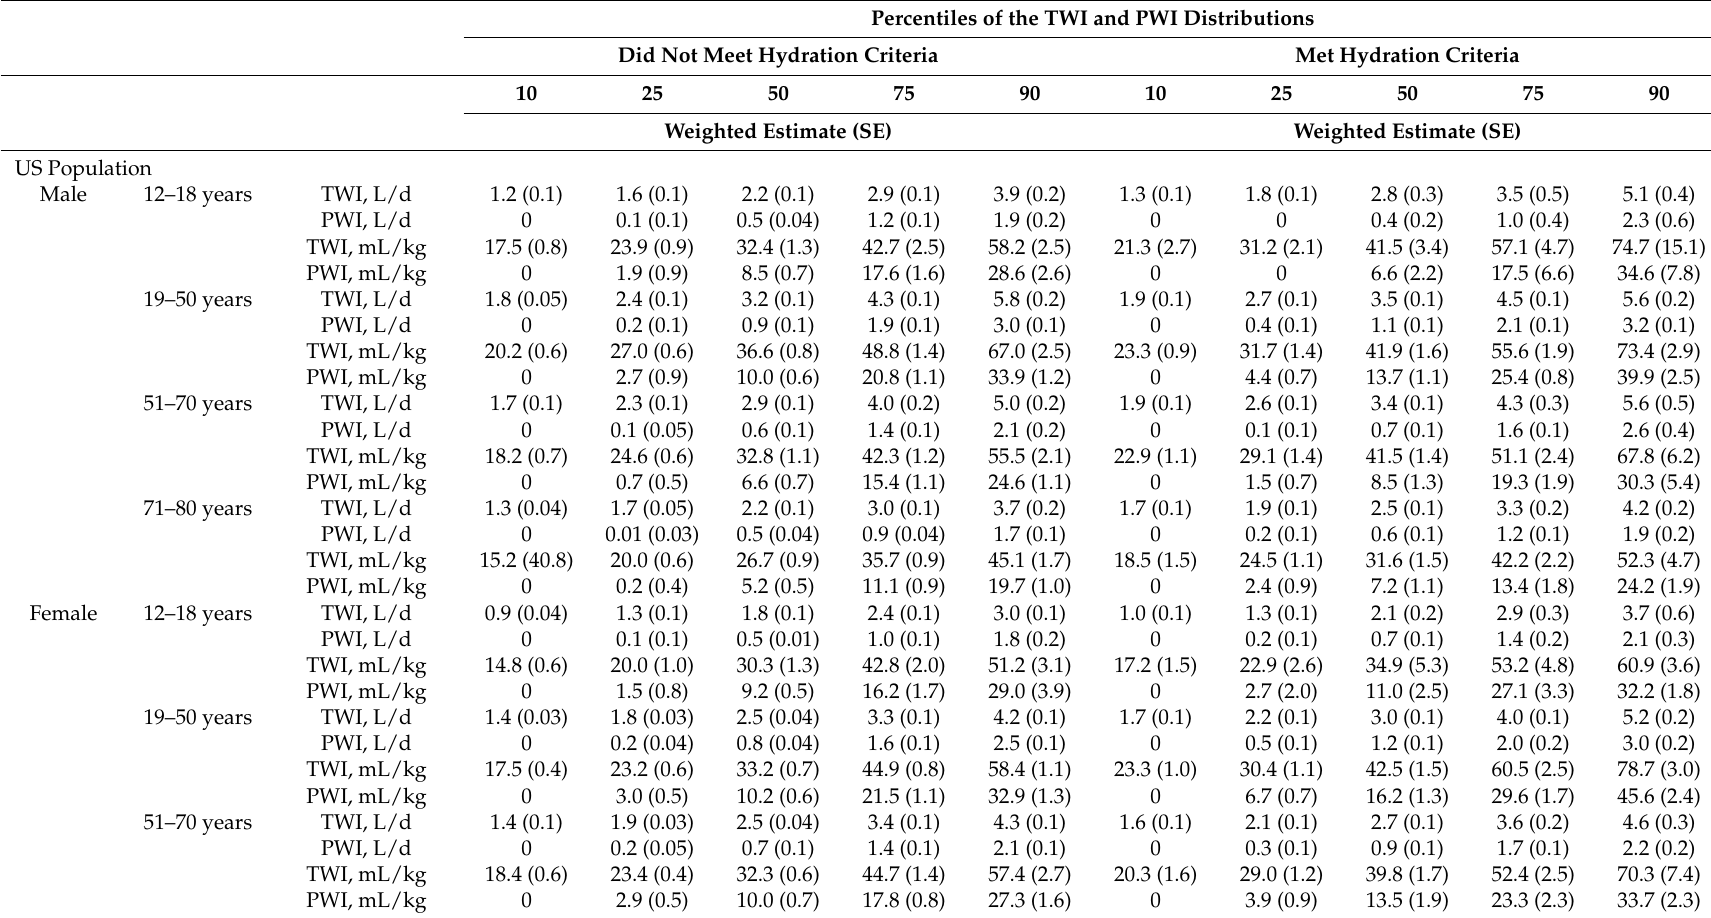
Table 8. Percentiles of the TWI and PWI distributions of the US population aged 12–80 years in 2009–2012 by hydration classification and life-stage